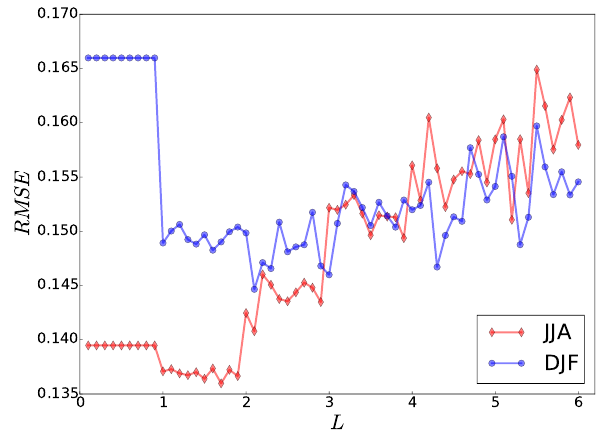
Figure 4. Field mean of seasonal near-surface temperature RMSE (K) of the analysis vs.